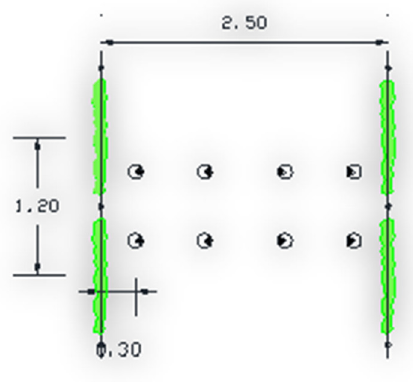
Scheme 1. Outline of LAI measurement